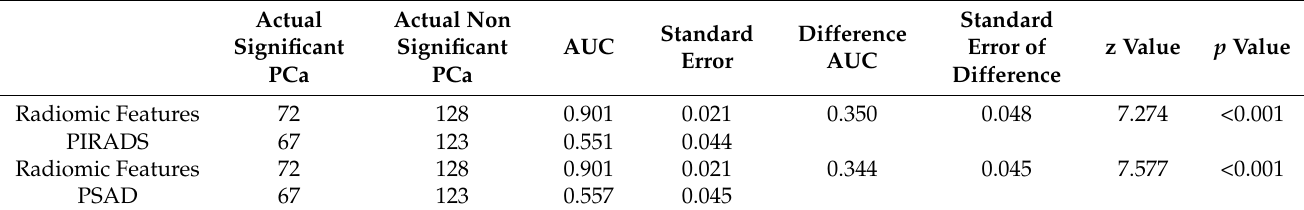
Table 3. AUC comparison between radiomic features and PIRADS, and radiomic features and